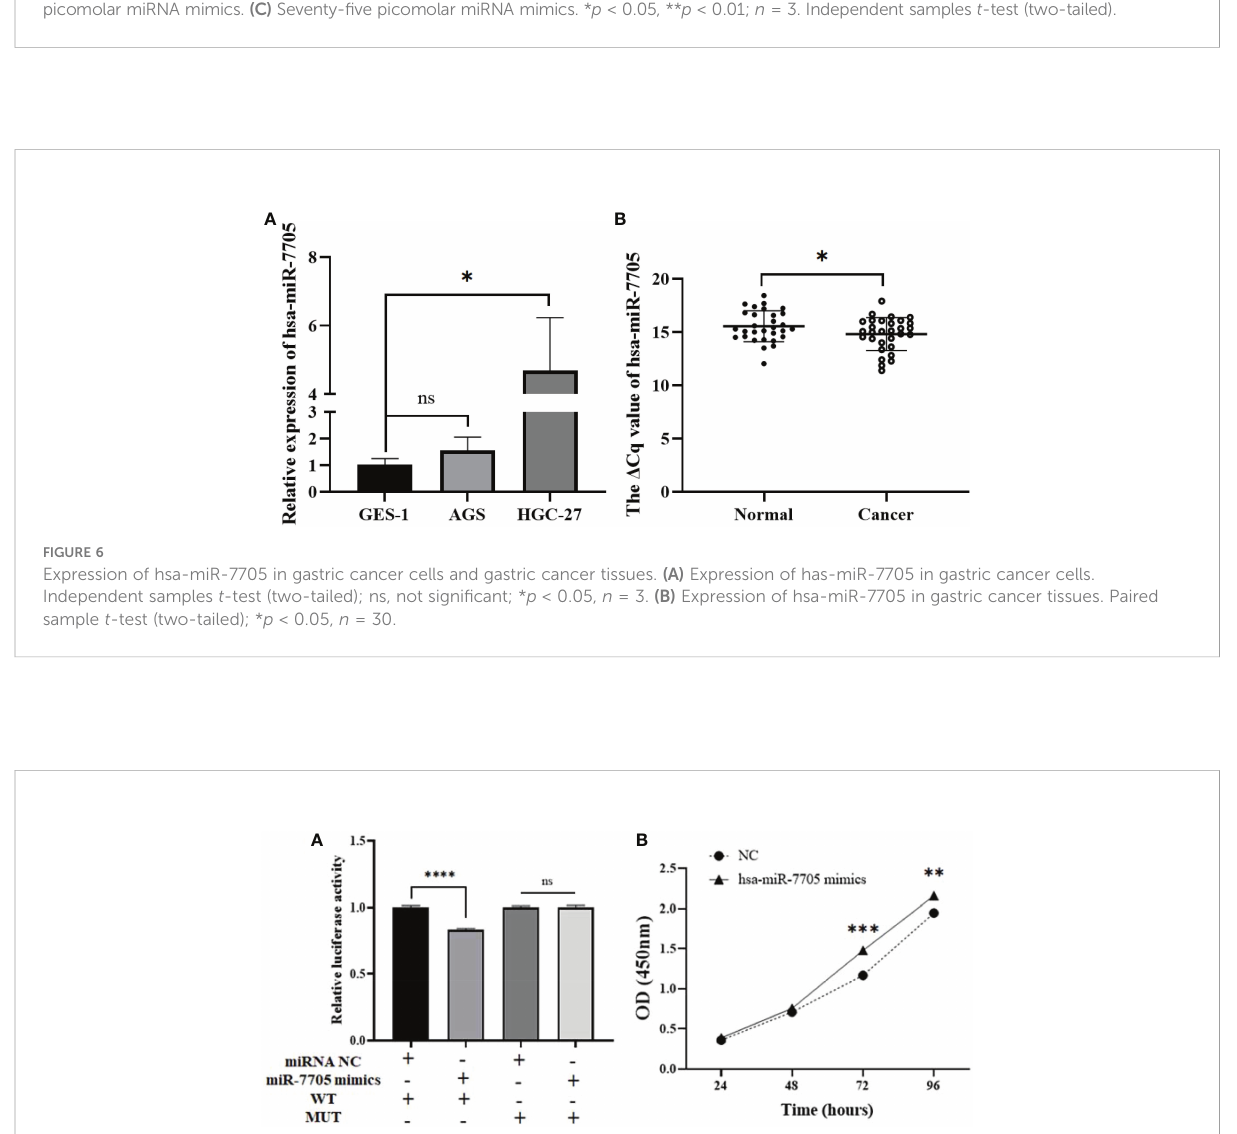
FIGURE 7 miRNA sponge function of hsa_circ_0061276. (A) Results of dual luciferase reporter gene experiment. Ns, not signi fi cant; **** p < 0.0001, n = 3. (B) Proliferation of HGC-27 cells after transfection with hsa-miR-7705 mimics. ** p < 0.01, *** p < 0.001; n = 3. Independent samples t -test (two- tailed) for A and B.